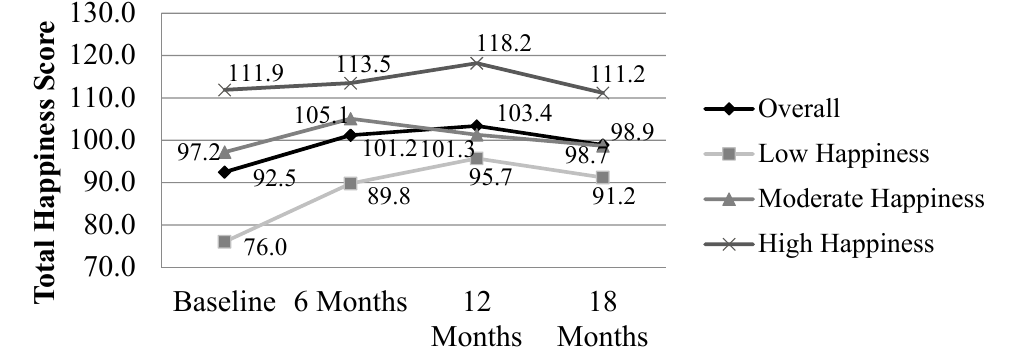
Figure 4. Total happiness score for women who completed case management ( n = 50). Repeated measures analysis, within- Ss effect, time: F = 6.148, p = 0.001; Repeated measures analysis, within- Ss effect, time x group: F = 2.302, p = 0.038; Repeated measures analysis, between- Ss effect, group; F = 21.726, p = 0.000.